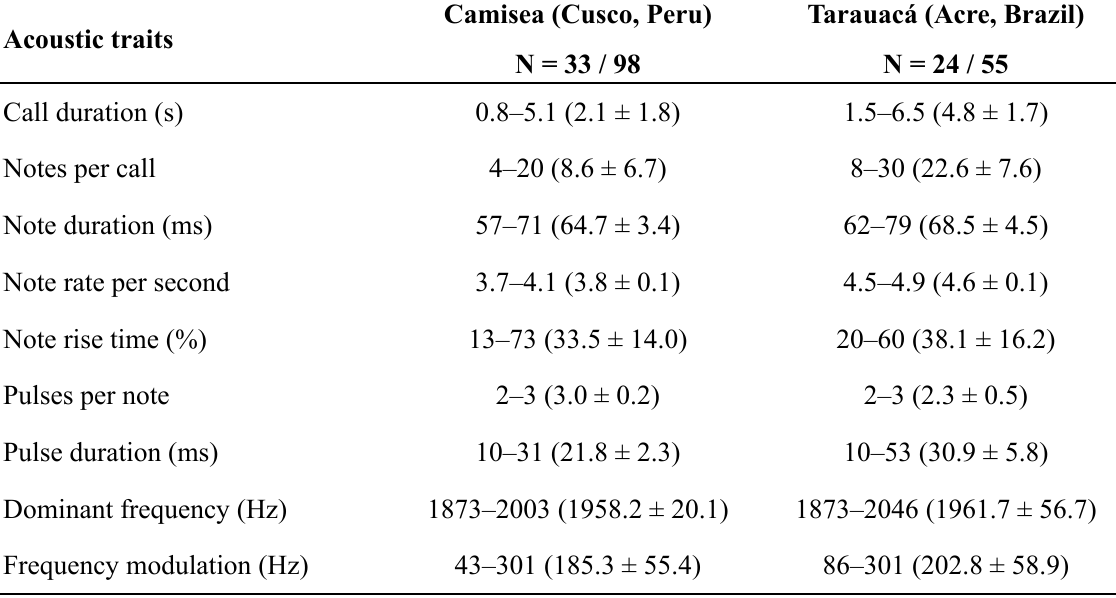
Table 2. Advertisement call traits of Adenomera simonstuarti (Angulo & Icochea, 2010) from southwestern Amazonia of Peru (type locality) and Brazil. One male was recorded from each locality. N = number of quantified notes and pulses, respectively. Values are presented as range (mean ± SD).